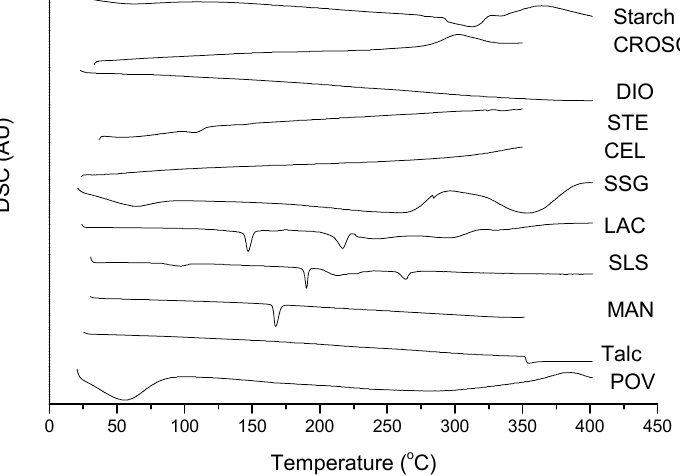
Figure 4. DSC curves of excipients of HCTZ tablets, under nitrogen atmosphere and a heating rate of 10 °C·min − 1 .